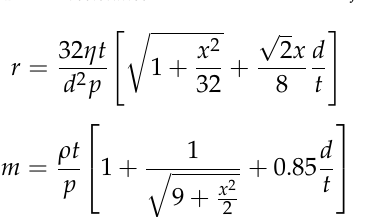
√ Here, x = d / 2 ωρ / η is the perforation constant, ω = 2 π f is the angular frequency, η is viscosity (1.6 × 10 − 5 m 2 /s), and ρ = air density (1.204 kg/m 3 ), with d , p , and t being the hole diameter, perforation ratio, and thickness of the panel, respectively. When the MPP is placed at a distance from the wall, the resulting surface impedance ( Z tot ) (Equation (5)) adds the impedance of the panel with the impedance of the air cavity ( Z cav ), having a depth of D (Equation (4)).